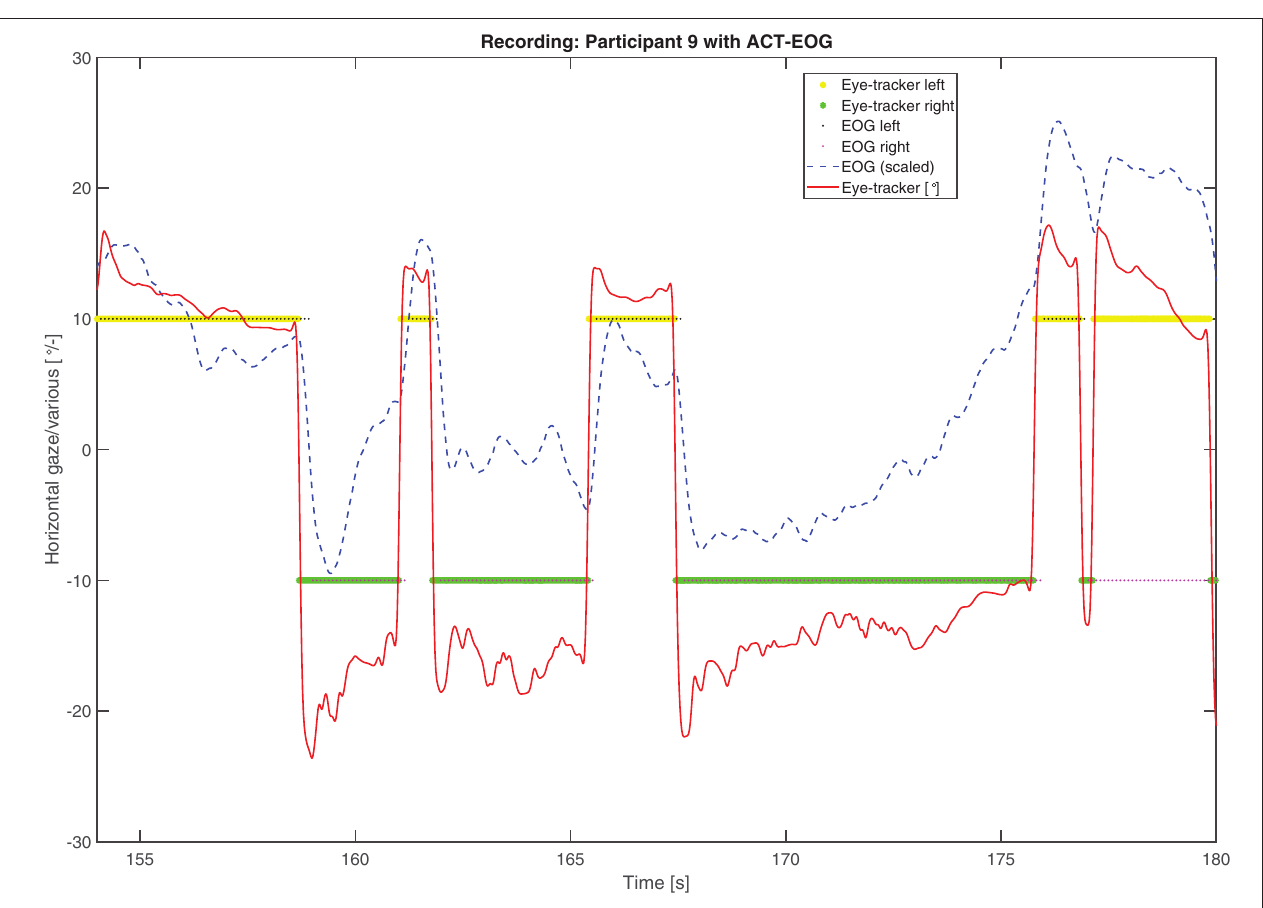
FIGURE 6 | An example of four channels showing the highest correlation (Corr). Reference signal in solid red, EOG signal in green, assumed saccade events in red overlaid on the green line, and detected saccades represented by black